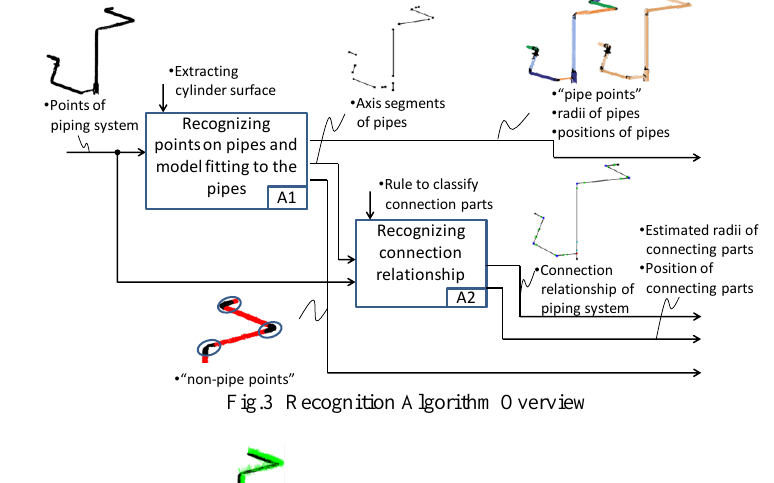
Fig.3 Recognition Algorithm Overview